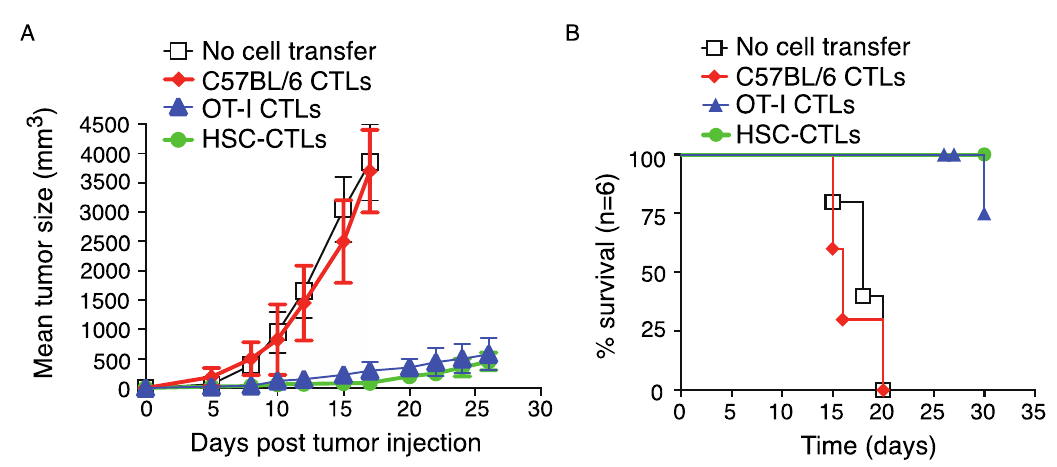
Figure 5. Immunization using genetic modification of HSCs following in vivo priming suppress tumor growth. T cell development and tumor injection were performed as described in Figure 4. ( A ) Tumor growth was monitored over time. Data are shown as mean tumor size ± sd from six individual mice and are representative of three experiments. ( B ) Mouse survival was assessed over 30 days (Kaplan–Meier survival analysis). Data are representative of three independent experiments ( n = 6).